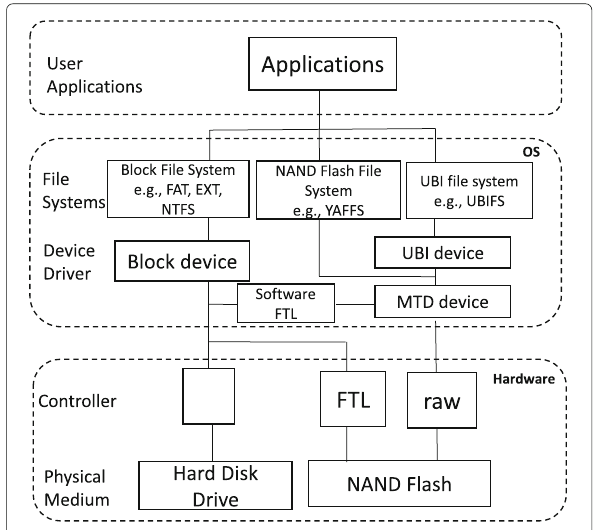
Fig. 1 The architecture of storage